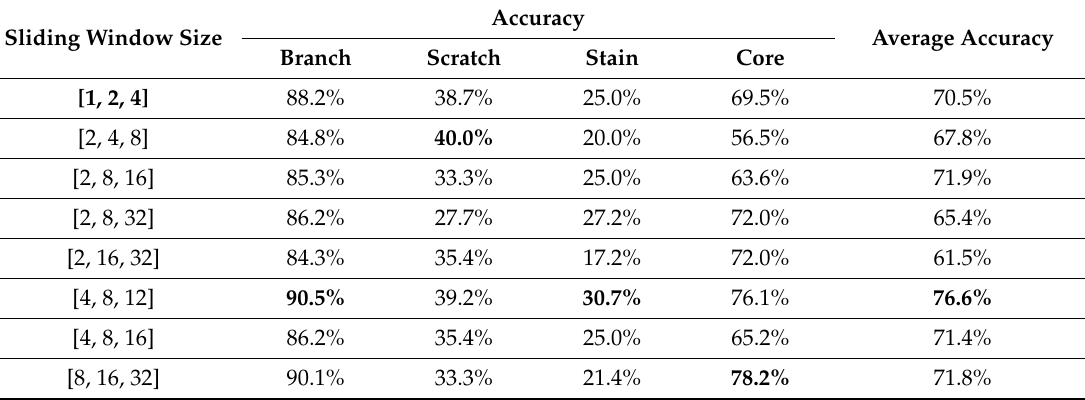
Table 2. Classification results with di ff erent sliding window size with AlexNet neural network. The best results are shown in